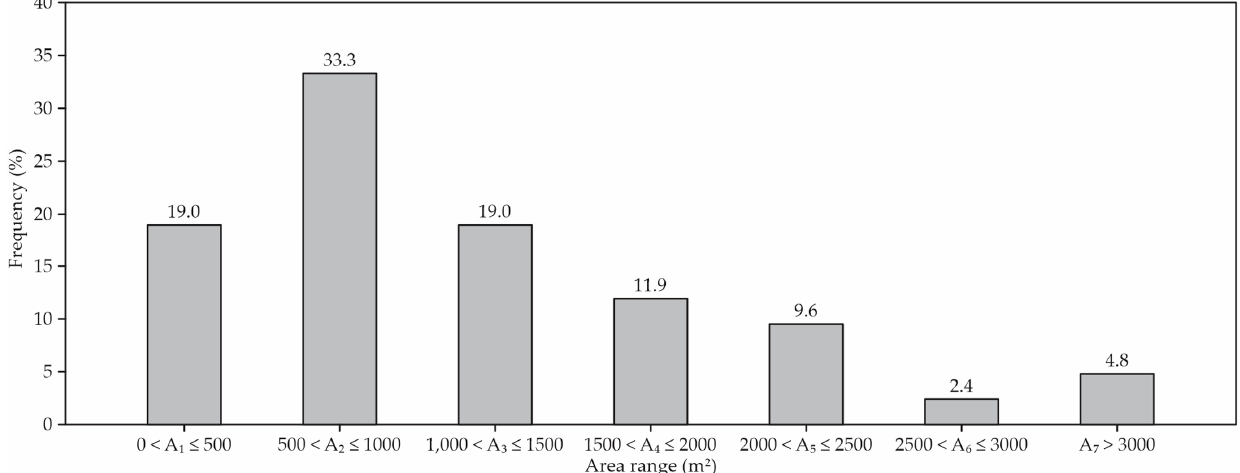
Figure 3. The frequency distribution of compost-bedded pack barn areas.